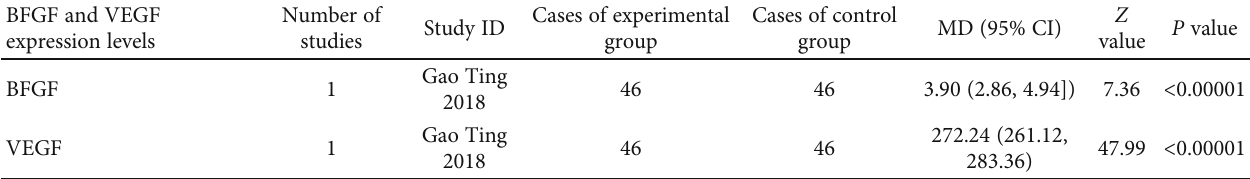
Table 10: ACU combined with routine treatment vs. routine treatment on BFGF and VEGF expression